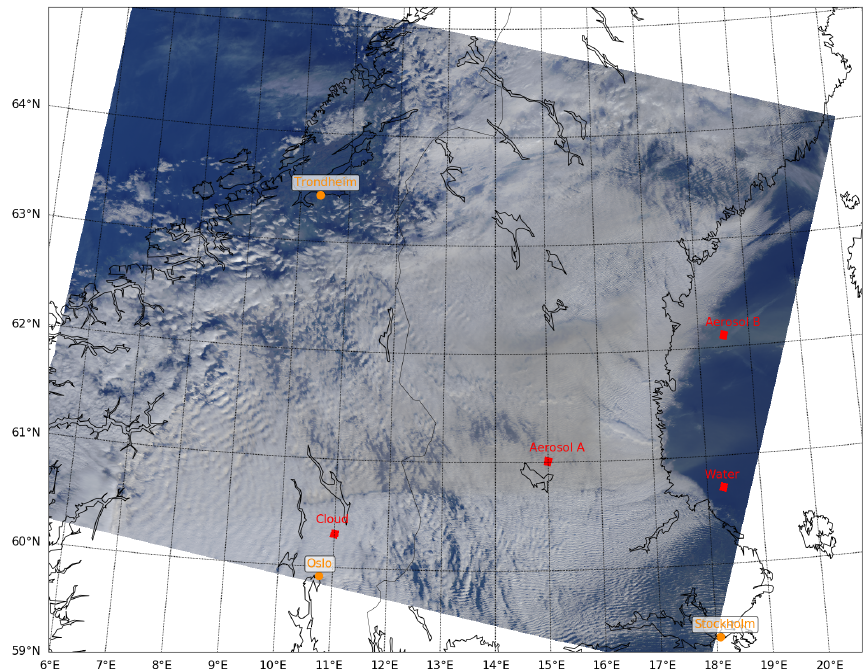
Figure 2. RGB from OLCI bands 3, 6, and 8 centred at 442.5, 560, and 665nm. Data from 2 October 2020, 09:33UTC.